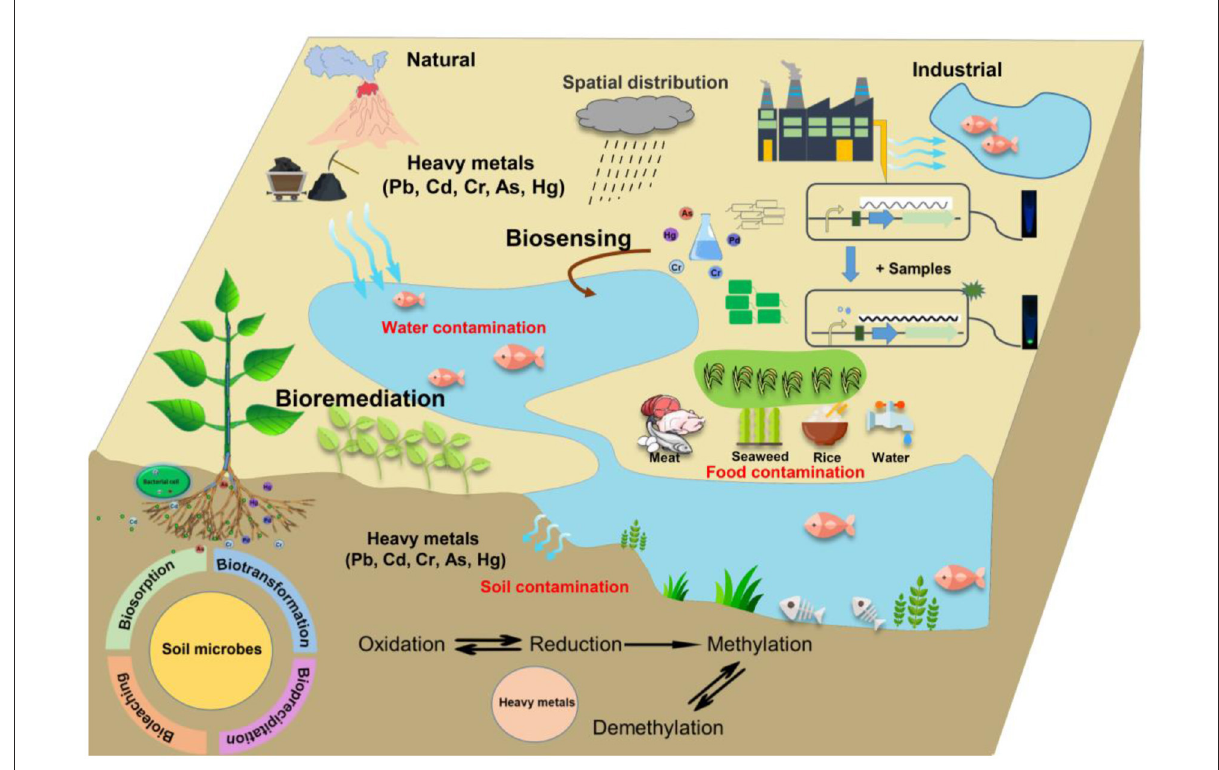
FIGURE1 The global trace elements cycle in the environment and its bioremediation and